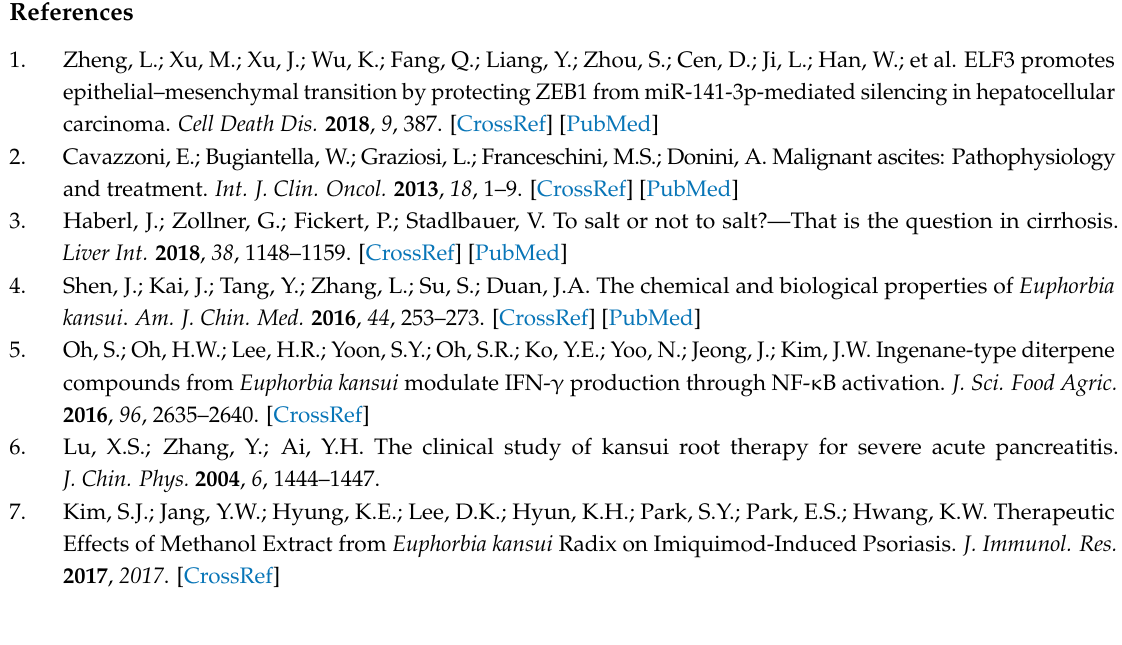
Supplementary Materials: The following are available online at http://www.mdpi.com/1420-3049/23/12/3246/ s1, Figure S1: The representative base peak intensity chromatograms of serum samples (A–D) from four groups by UPLC-Q-TOF in positive (Left) and negative (Right) modes, Figure S2: Representative base peak intensity chromatograms of urinary samples (E-H) of four groups by UHPLC-Q-TOF in positive (Left) and negative (Right) modes, Figure S3: The response permutation test plots ( n = 200) for the PLS-DA models for serum (A) and urine samples (B) in positive mode, Figure S4: The average relative intensity changes of urine endogenous metabolites from different groups, Table S1: UPLC-Q-TOF-MS data for Identification results of potential biomarkers, Figure S5: The network of potential metabolites for pathway-based genes, Figure S6: The extended protein-protein network of metabolites-related genes, Figure S7: The compound-target network representing the effect of treating malignant ascites by V-kansui, Figure S8: The compound-target-metabolite network. Author Contributions: Conceptualization, Z.L. and T.Y.; methodology, W.K. and B.B.; performing the experiment, G.J. and Z.Y.; data acquisition, Z.Q.; writing—original draft preparation, Z.Y.; writing—review and editing, Y.W. and